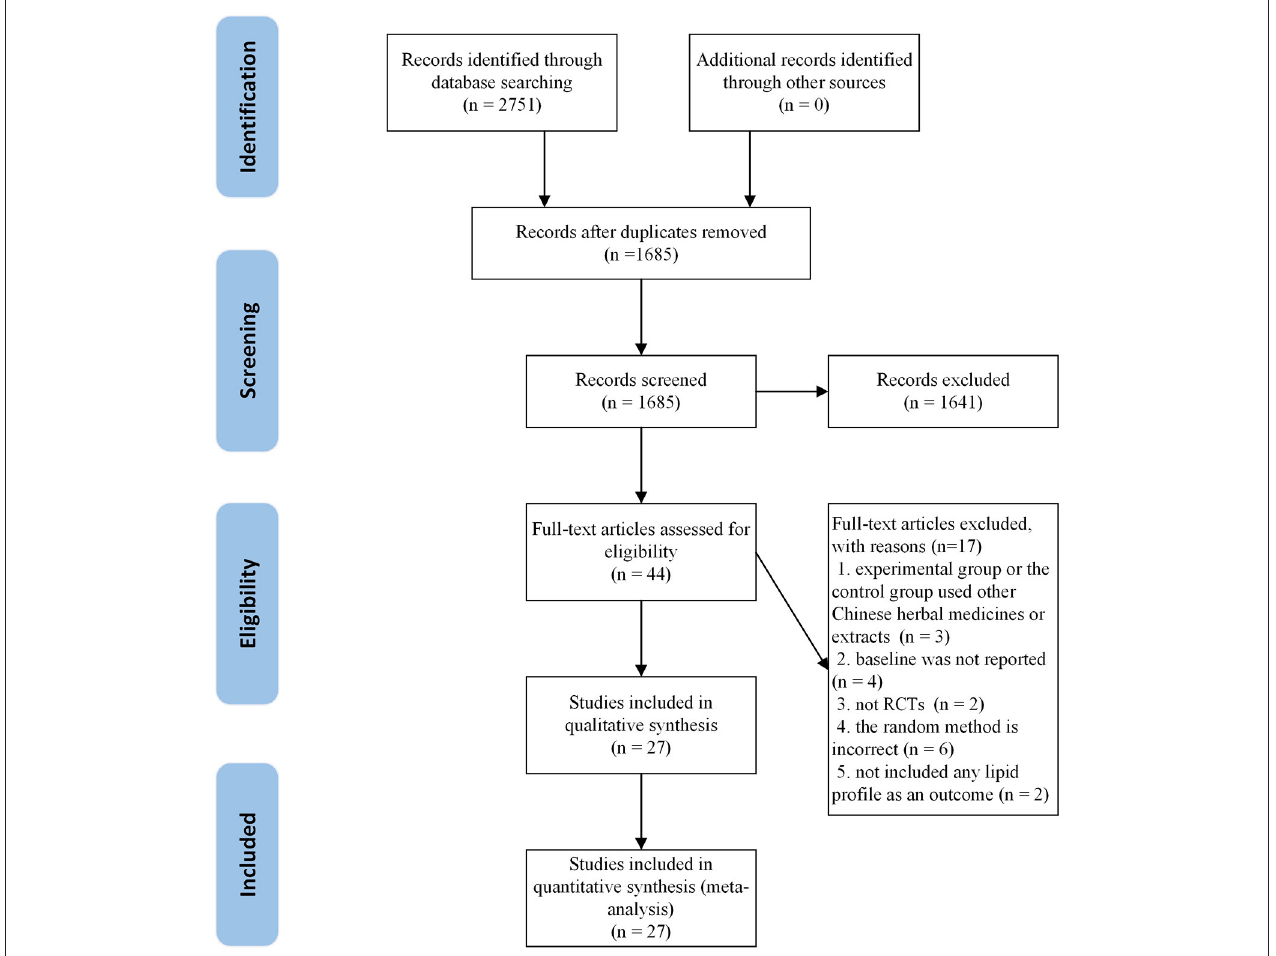
FIGURE 1 | The flow chart of the study selection process showing how to screen eligible randomized controlled